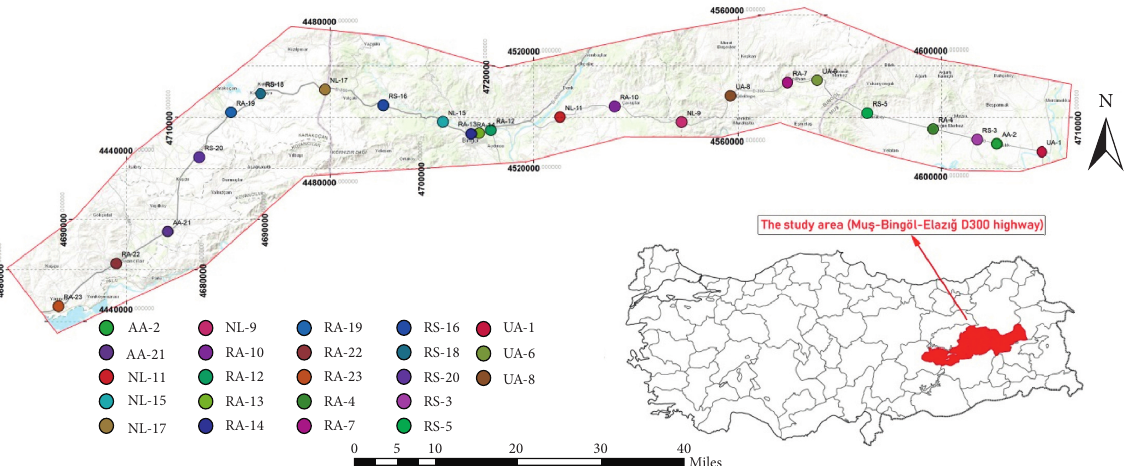
Figure 1: Research area and location of sampling points.